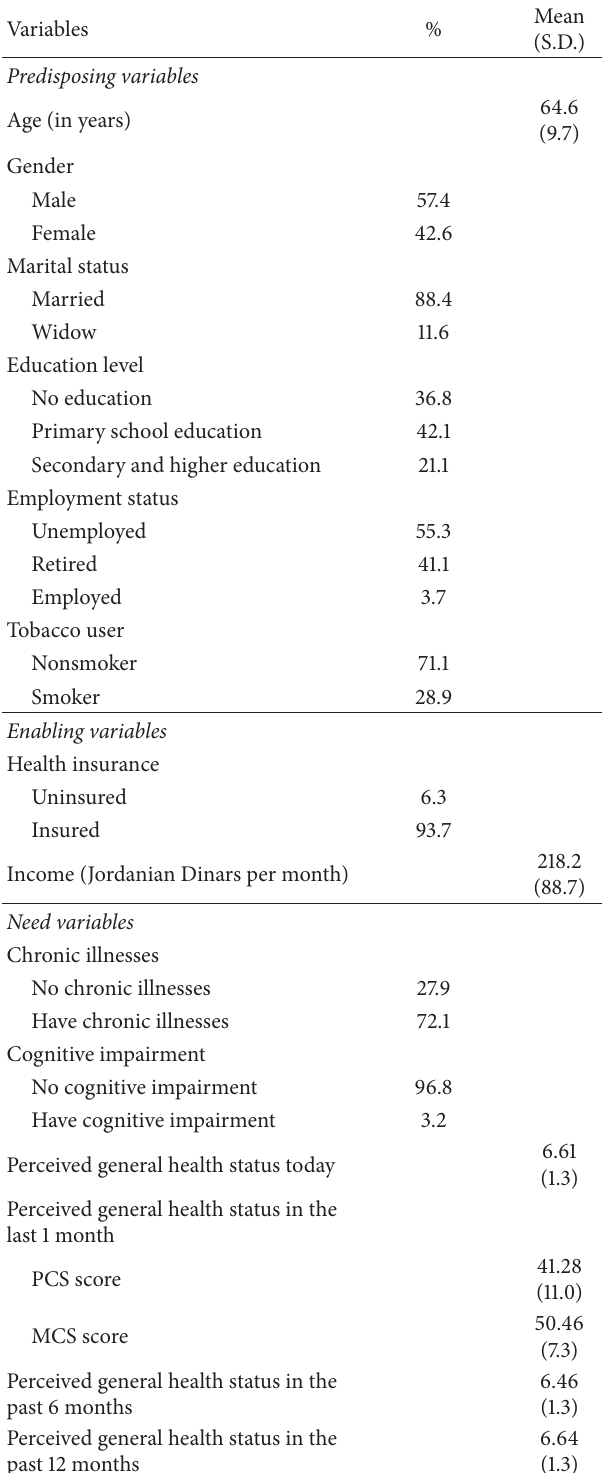
Table 1: Descriptive statistics of the predisposing, enabling, and need variables of older adult participants ( 𝑛 = 190